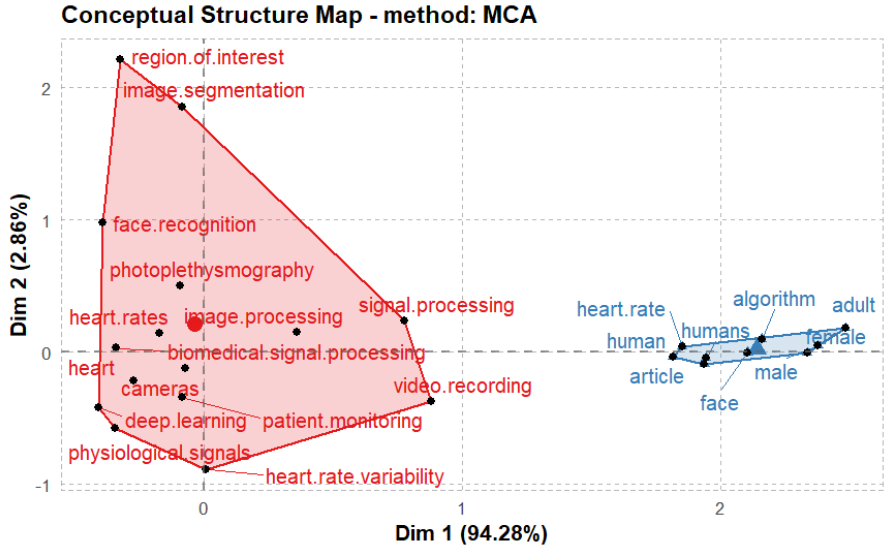
Figure 4. Conceptual framework